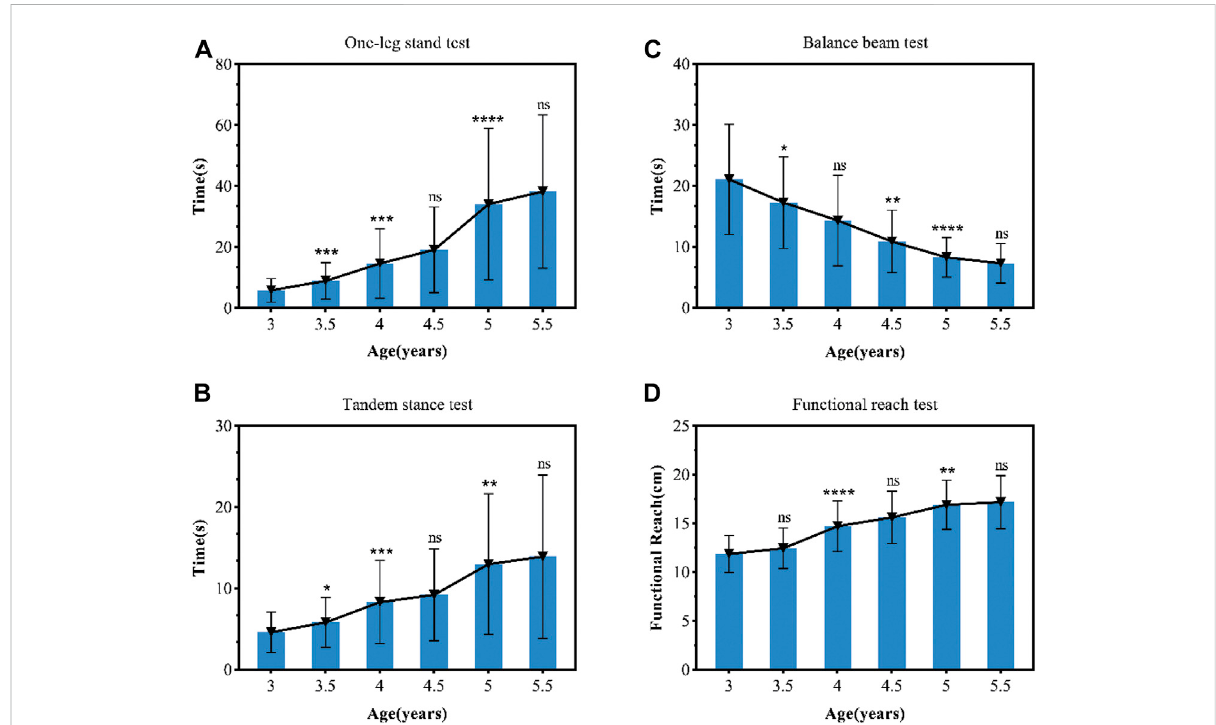
FIGURE 1 Static and dynamic balance tests result. Static and dynamic balance tests result (mean ± standard deviation) in preschool children from 3 to 5.5 years old group (using one-way ANOVA). Static balance tests of the one-leg stand (A) and tandem stance (B) ; dynamic balance tests of balance beam test (C) ; and functional reach test (D) . The (*) indicates signi fi cant difference between the previous age group, * p < 0.05, and ns, no signi fi cant difference between the previous age group. In the BBT test, shorter time indicated a better